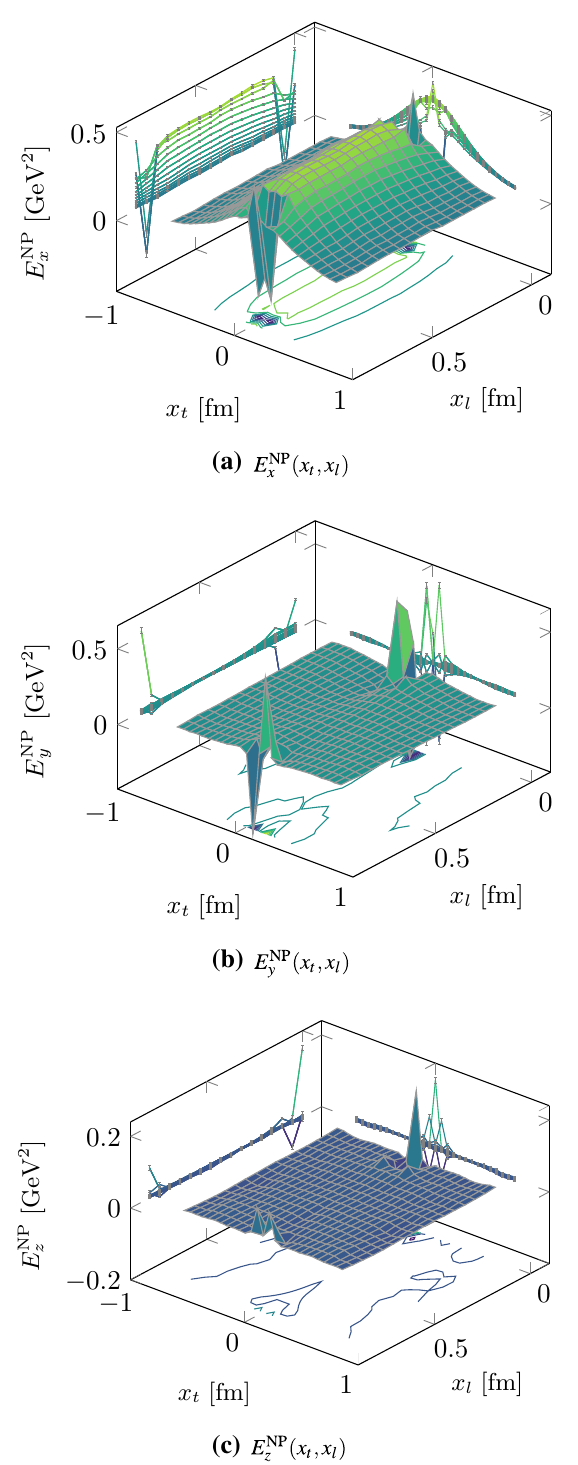
Fig. 4 Surface and contour plots for the three components of the non- perturbative chromoelectric field, E NP ≡ E − E C , at β = 6 . 370 and d = 0 . 85 fm. All plotted quantities are in physical units